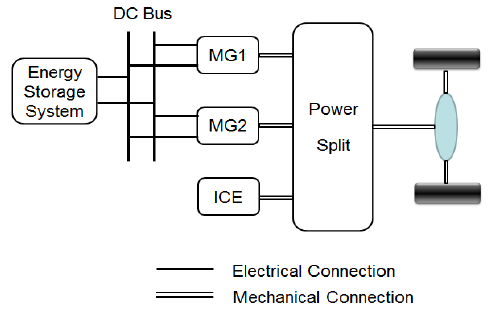
Figure 11. The drivetrain configuration of the HEV.